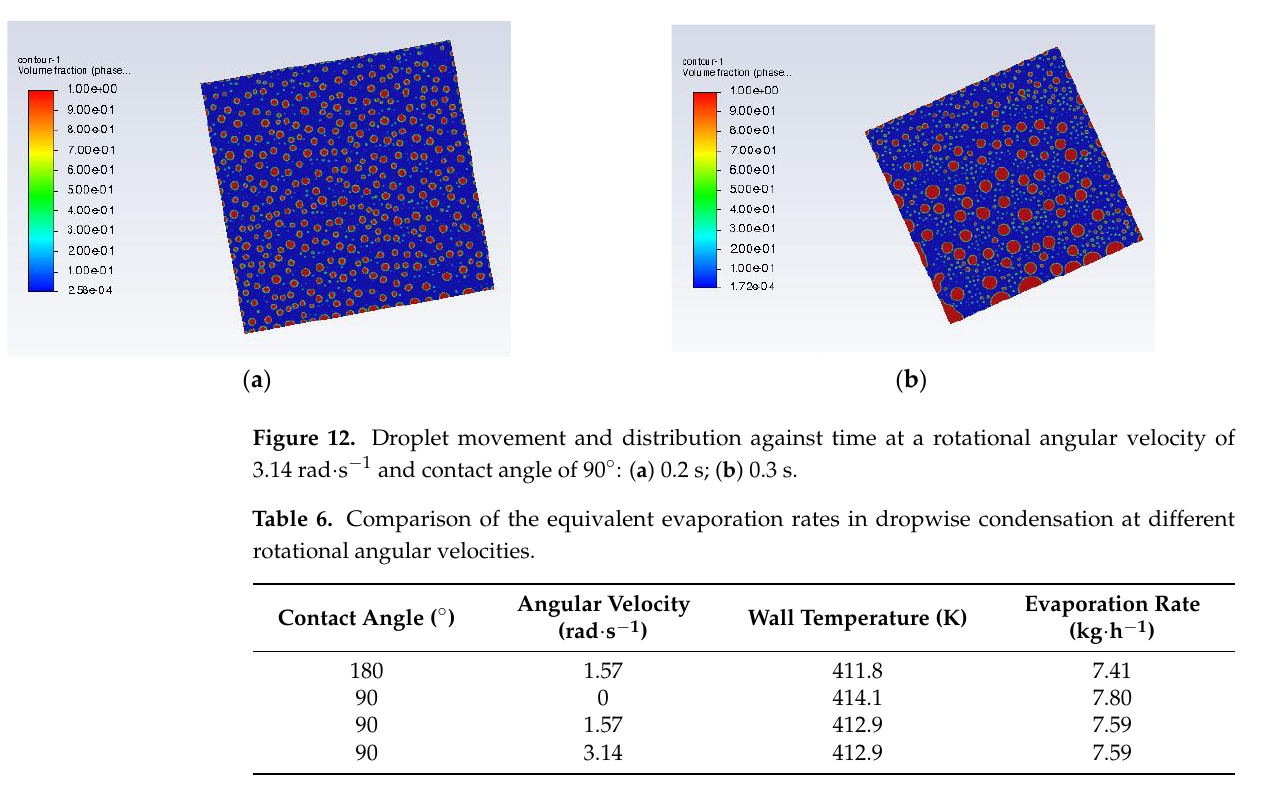
Table 5. Comparison of the equivalent evaporation rates in filmwise condensation at different rota- tional angular velocities.